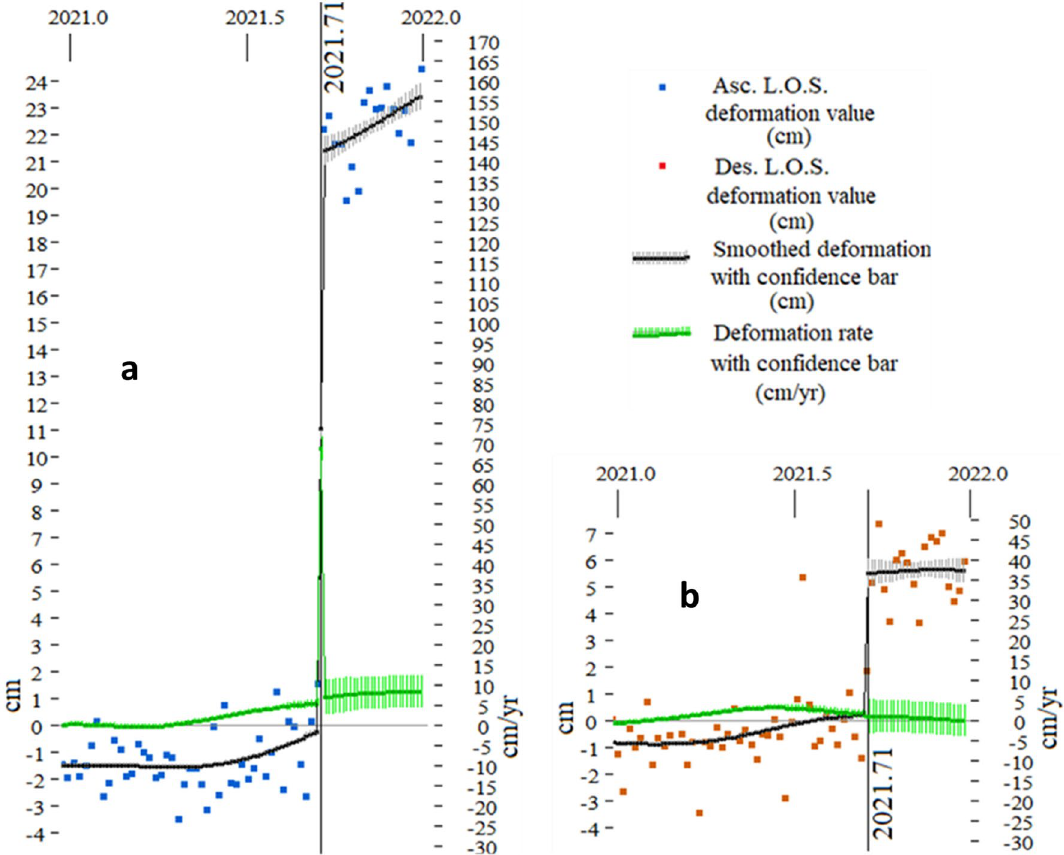
Figure 2. Input deformation data for a pixel close to the maximum deformation site with UTM coordinates (218,000,3,166,000). Dots denote the discrete satellite data, using blue color for ascending ( a ) and red for descending ( b ) LOS displacements. Black lines are smoothed deformation (cm) (left axis) with confidence bars for one standard deviation. Smoothing approach is described in the Methods section. Green lines are smoothed deformation rate (cm/yr) (right axis) with confidence bars for one standard deviation. At 2021.71 (09/17/2021) there is a clear jump in the deformation record. Pixel location is shown in Supplementary Fig. 3. Matlab software (www. mathw orks. com) and Microsoft PowerPoint 2016 were used to create this